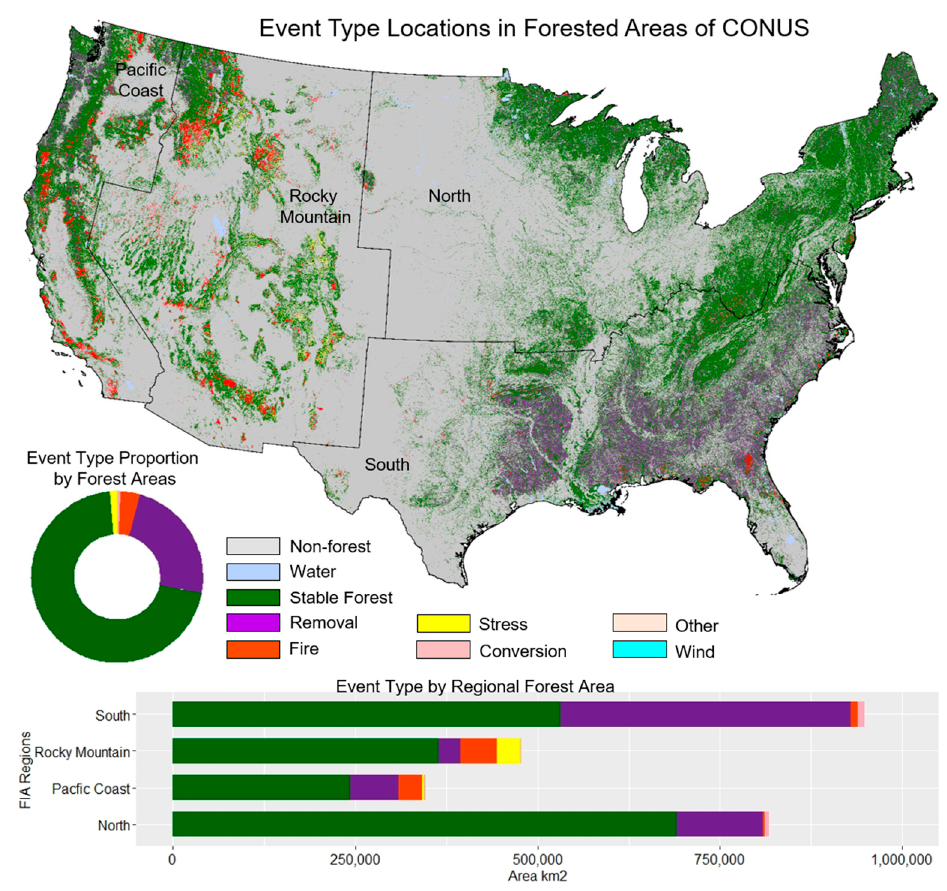
Figure 1. Forest canopy loss events types in CONUS (1986–2010). The donut chart shows national proportions for each event type in forest area. The bar graph breaks event type areas by FIA region. Event types were mapped using empirical modeling, a probabilistic training data set, and predictors from an ensemble of disturbance algorithms using NASA’s High End Computing Capabilities (HECC).